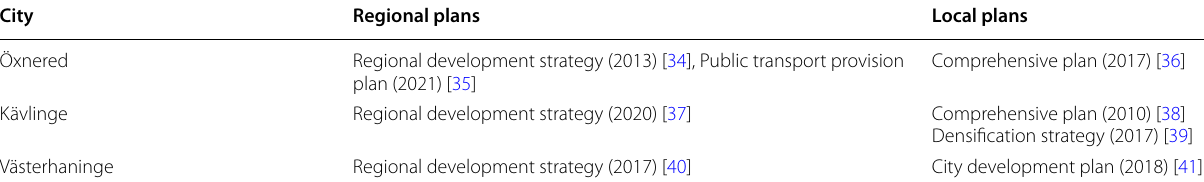
Table 2 Cities and plans analysed City Regional